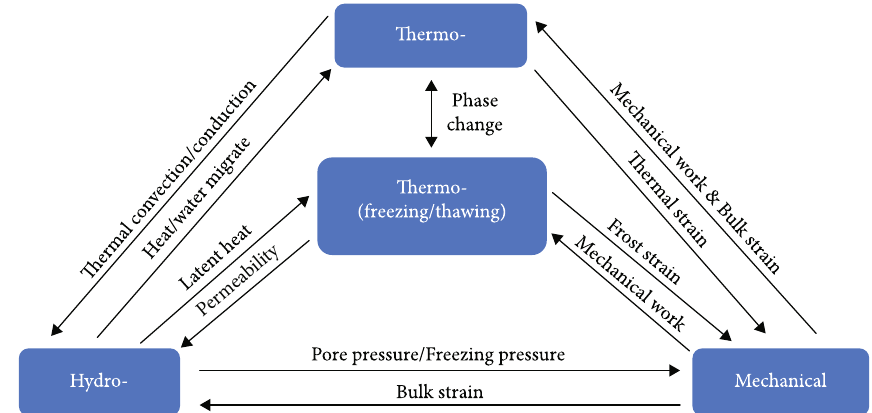
Figure 8: Schematic of thermo-hydro-mechanical (THM) coupling under freezing and thawing